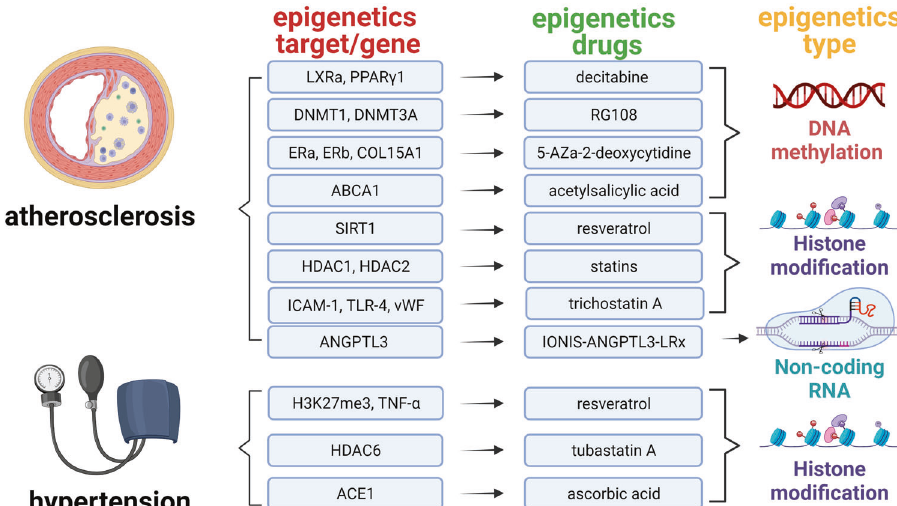
Fig. 5 Epigenetics-related targets and drugs in atherosclerosis and hypertension. This fi gure was created with the aid of Biorender (https:// biorender.com/). LXRa, liver X receptor a, PPAR γ 1 peroxisome proliferator-activated receptor γ 1, DNMTs DNA methyltransferases, ER